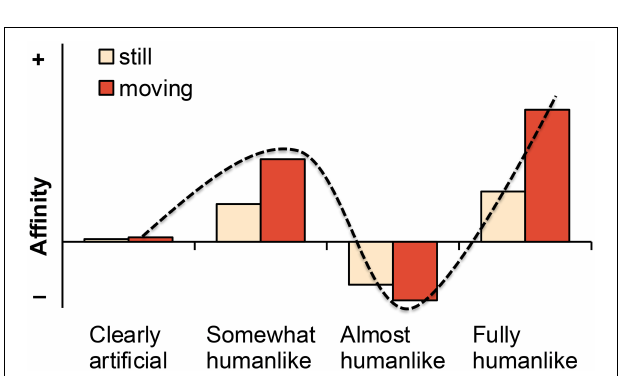
FIGURE 3 | Predicted affinity levels (from negative to positive) for still and moving versions of characters representing different human-likeness levels. The characteristic uncanny curve is overlain on the data for